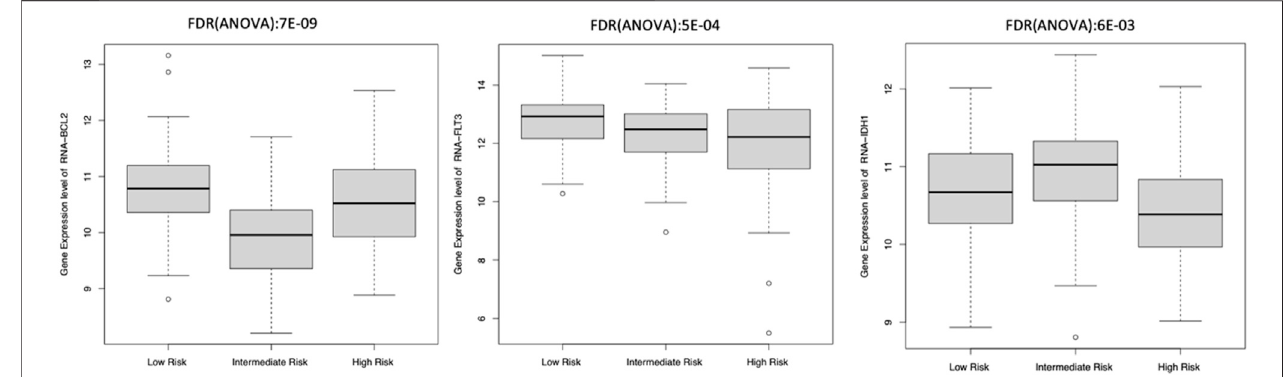
FIGURE 6 | BCL2, FLT3, and IDH1 gene